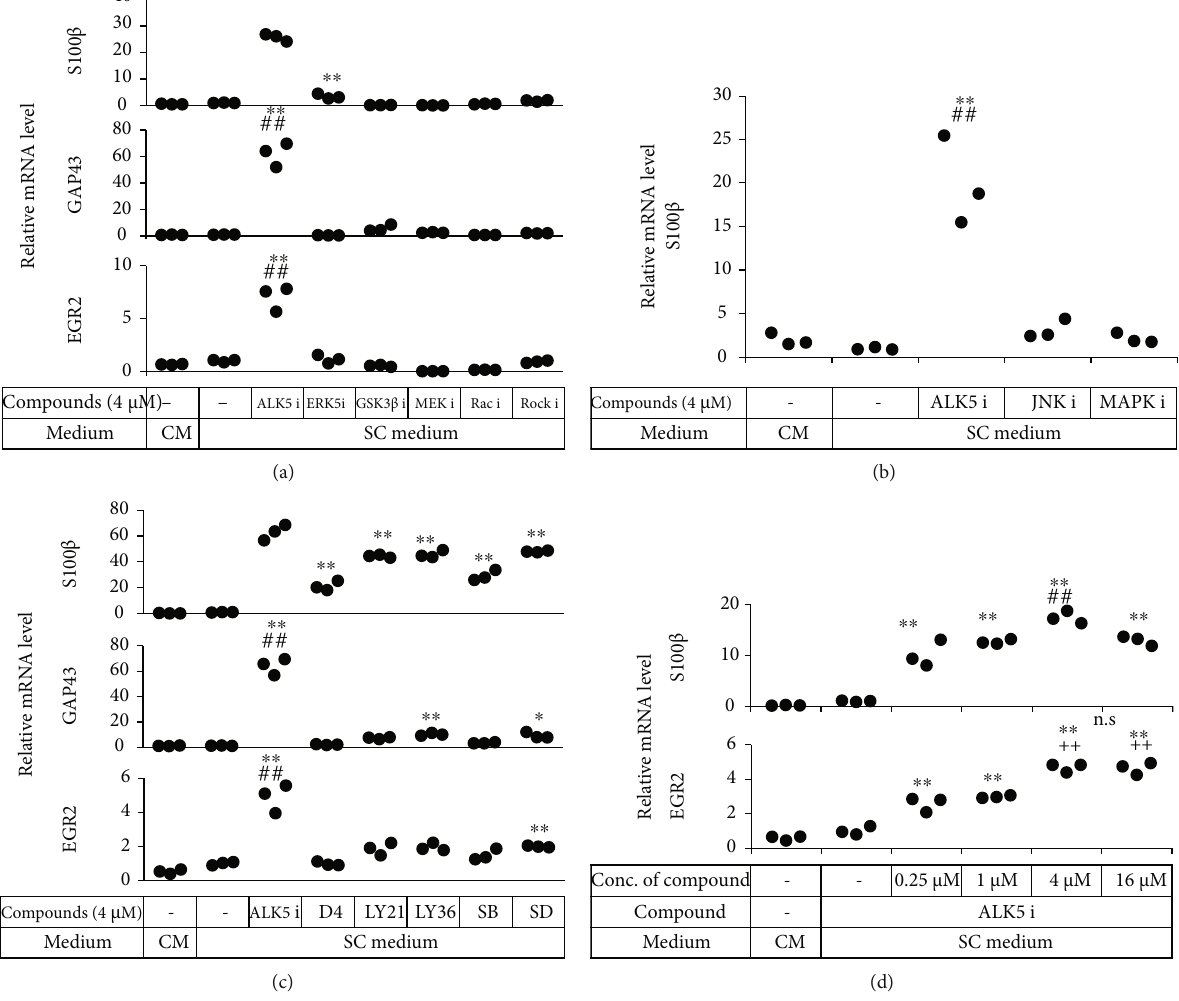
Figure 2: ALK5 i II prompted hADSCs to express SC markers. Human ADSCs were seeded in 24-well plates and cultured in a complete medium or a SC medium supplemented with the compounds indicated. Various signal pathway inhibitors (a, b) and TGF β R inhibitors (c) were compared, while various concentrations of ALK5 i II were also tested (d). After 14 days of culture, RNA was extracted from the cells and subjected to real-time RT-PCR analysis. Each dot represents triplicate value of relative mRNA level for the indicated genes. ∗ p < 0 : 05 and ∗∗ p < 0 : 01 vs. ADSCs cultured in the SC medium. ## p < 0 : 01 vs. all the other groups. ++ p < 0 : 01 vs. ADSCs cultured in the SC medium supplemented with ALK5 i II at 0, 0.25, or 1 μ M. n.s.: no signi fi cant di ff erence between the indicated groups. Experiments were repeated three